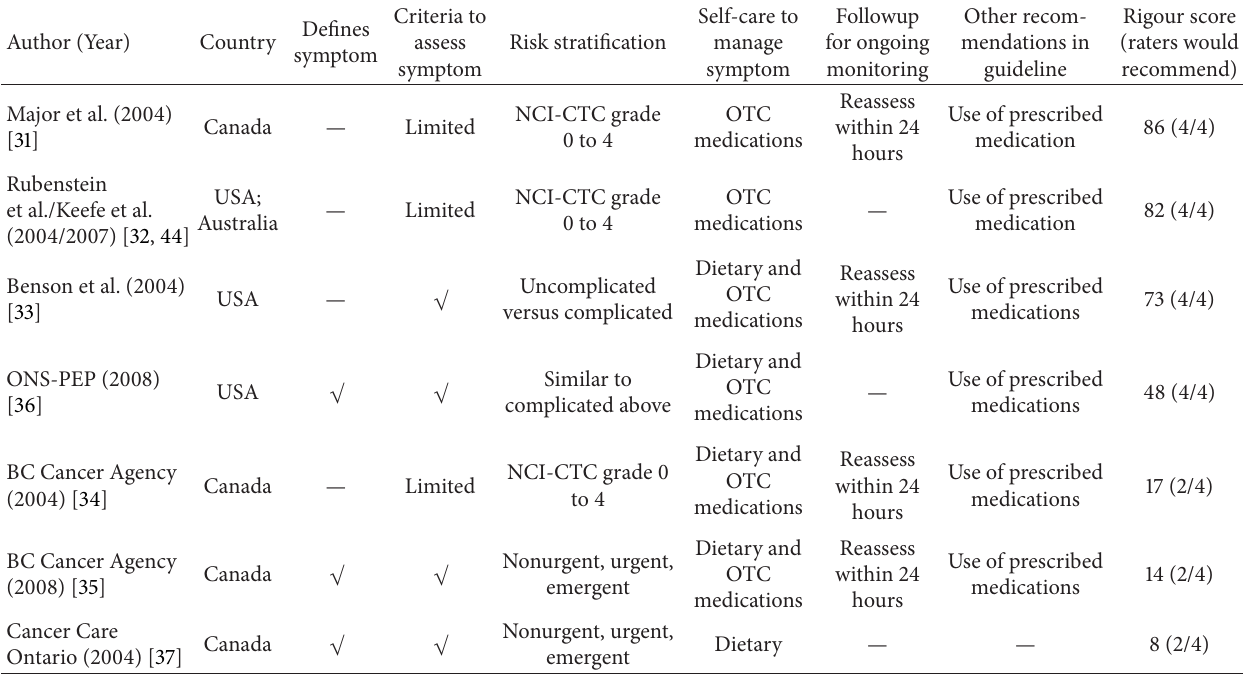
Table 3: Characteristics of guidelines about diarrhea ( 𝑛 = 7 ).